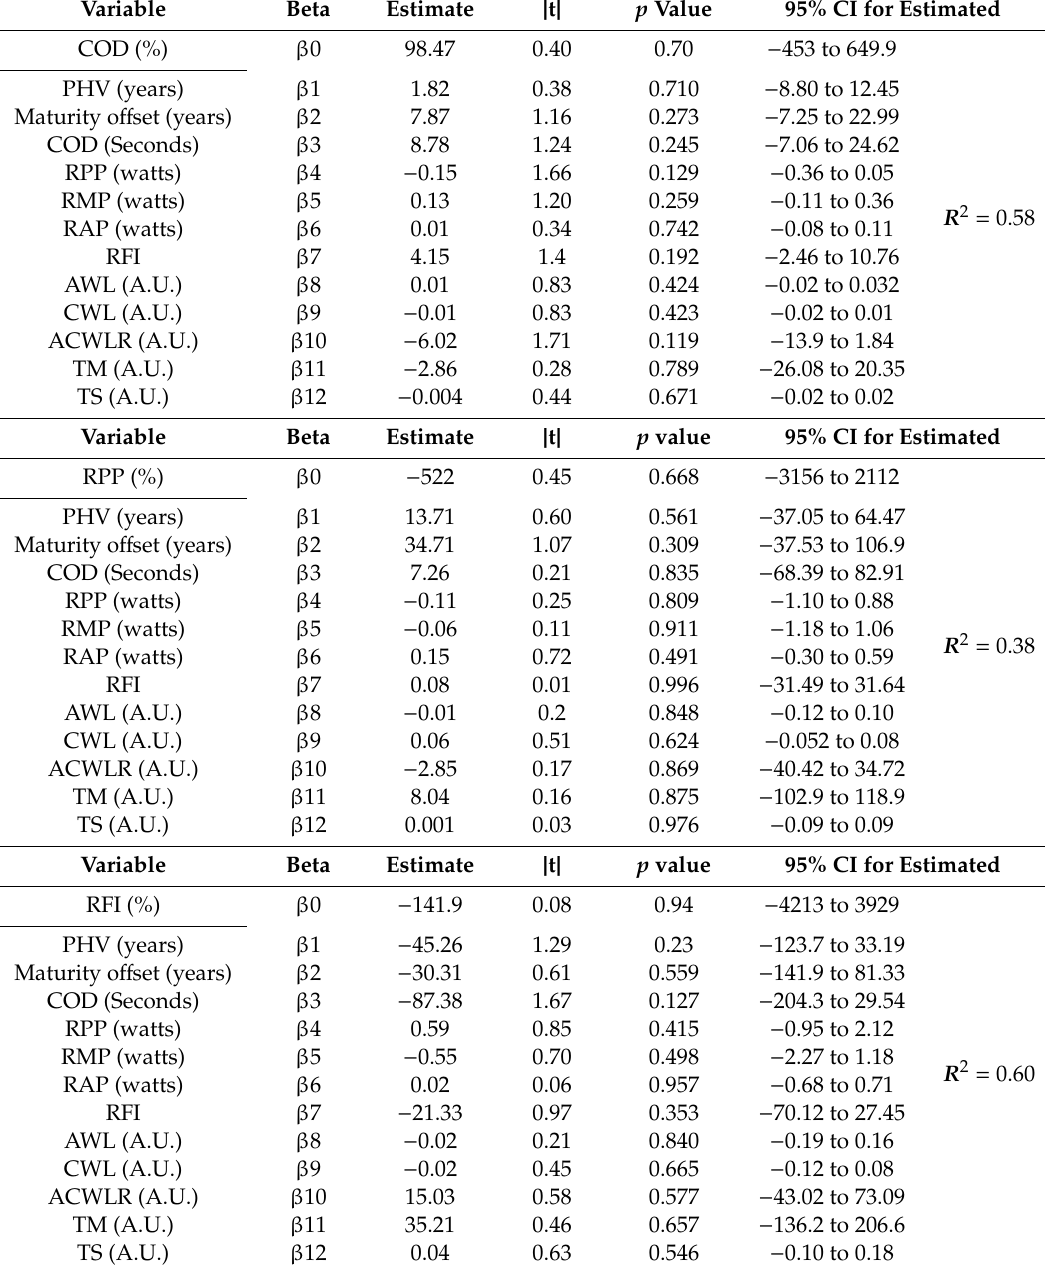
Table 3. Multiple linear regression analysis: percentage of change between EaS and EnS in COD and anaerobic power variables with workload parameters, baseline fitness levels, and